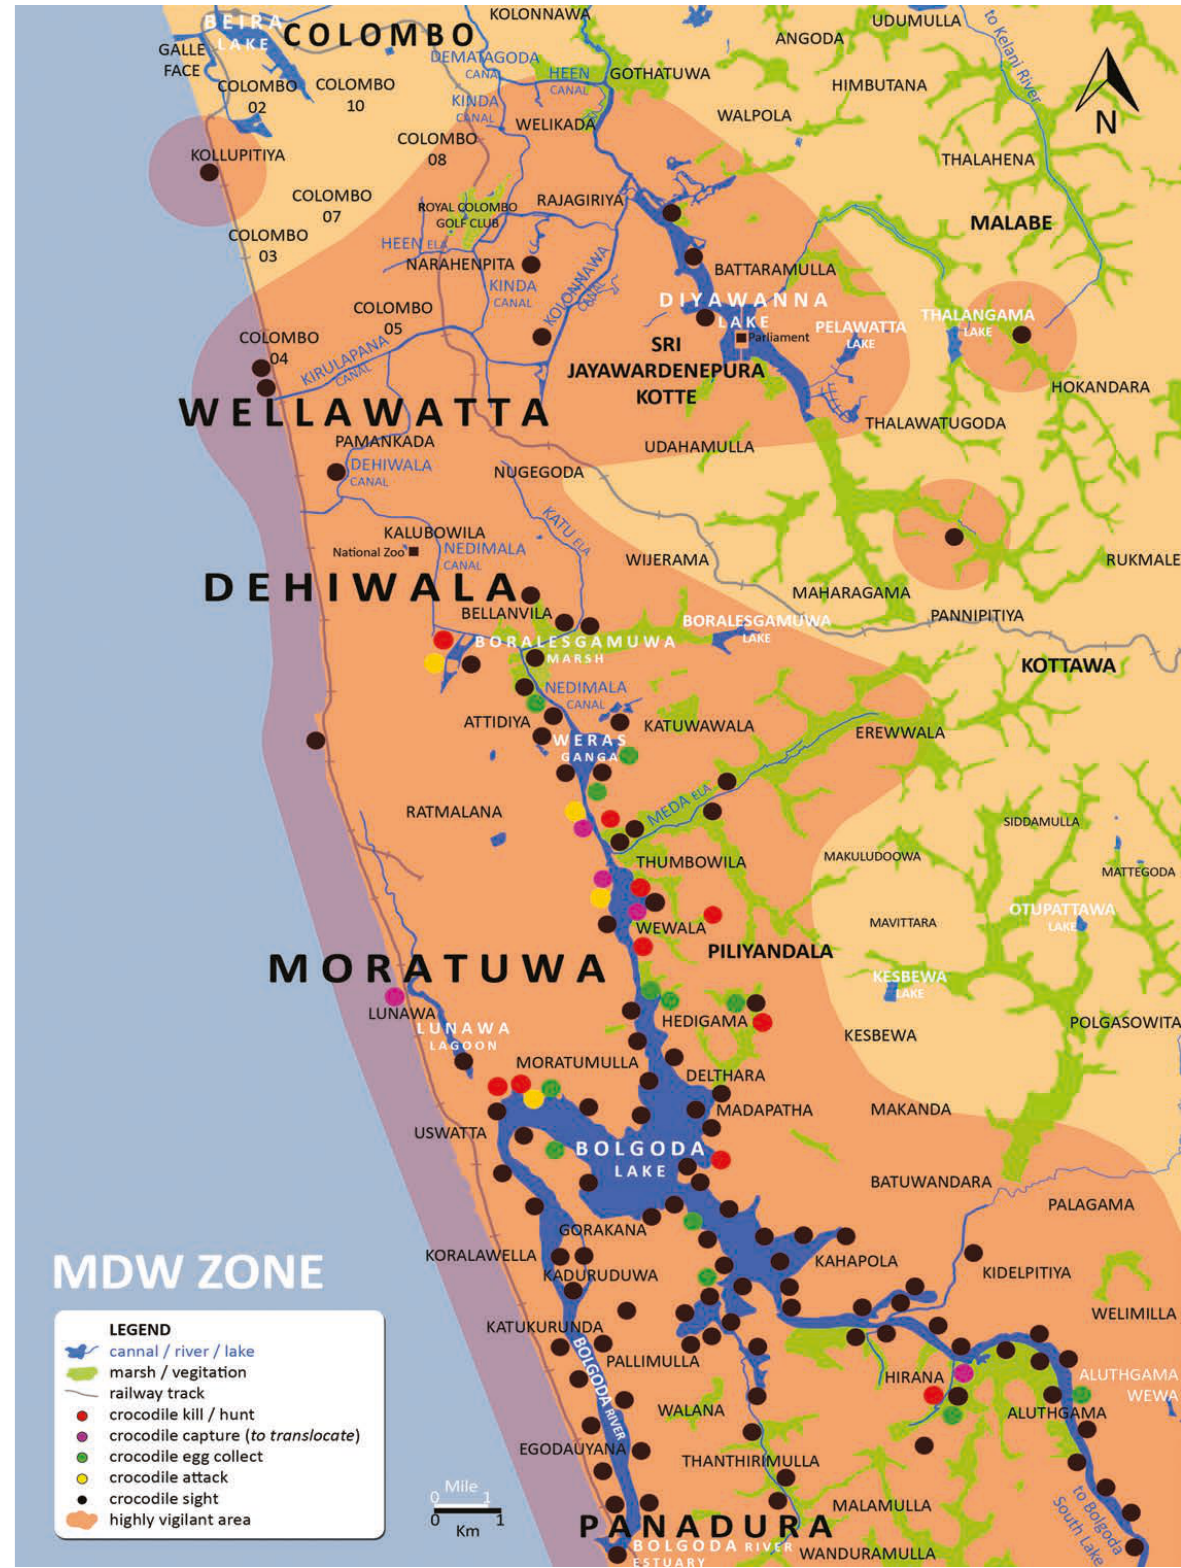
Image 4. Map of Moratuwa–Dehiwala–Wallawatta Crocodile Vigilance